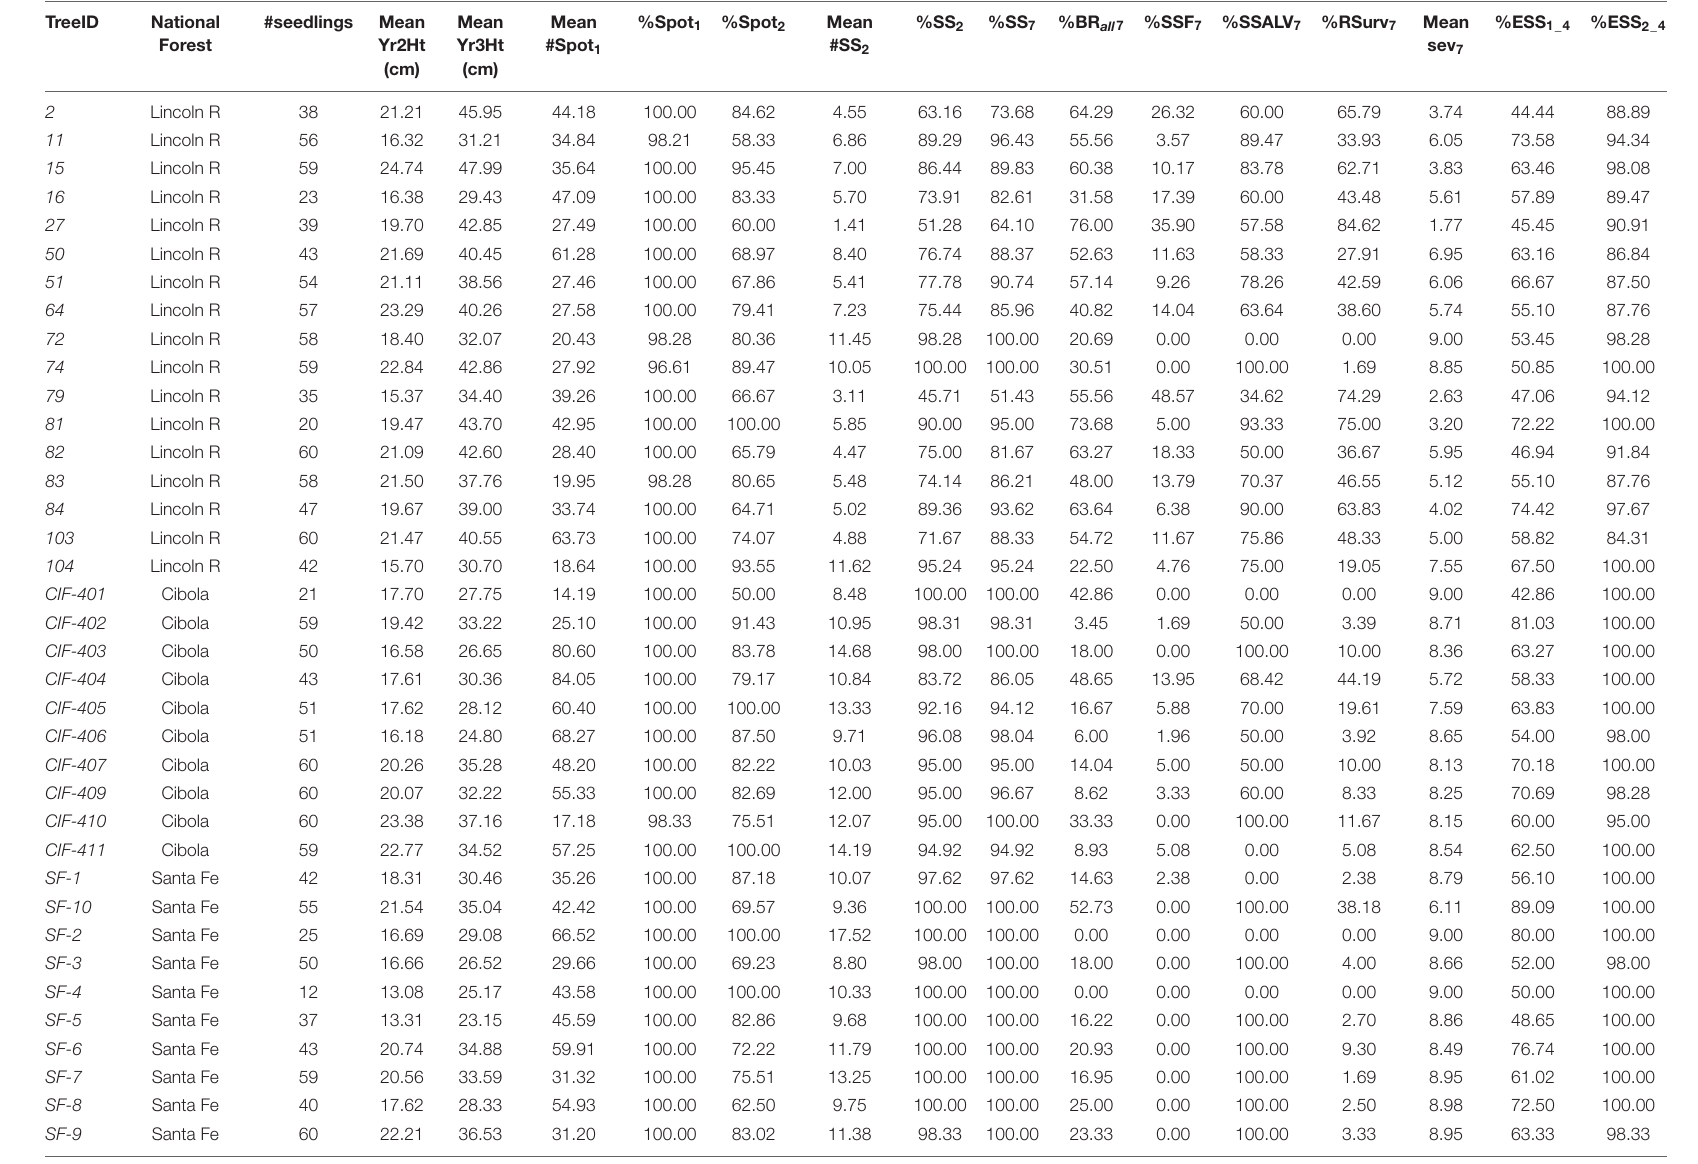
TABLE 3 | Family means for progeny from 40 open pollinated Pinus strobiformis trees.